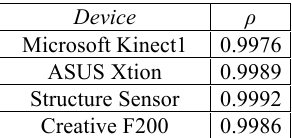
Table 3. Correlation factor between the values of random error σ r at the different distances and the related